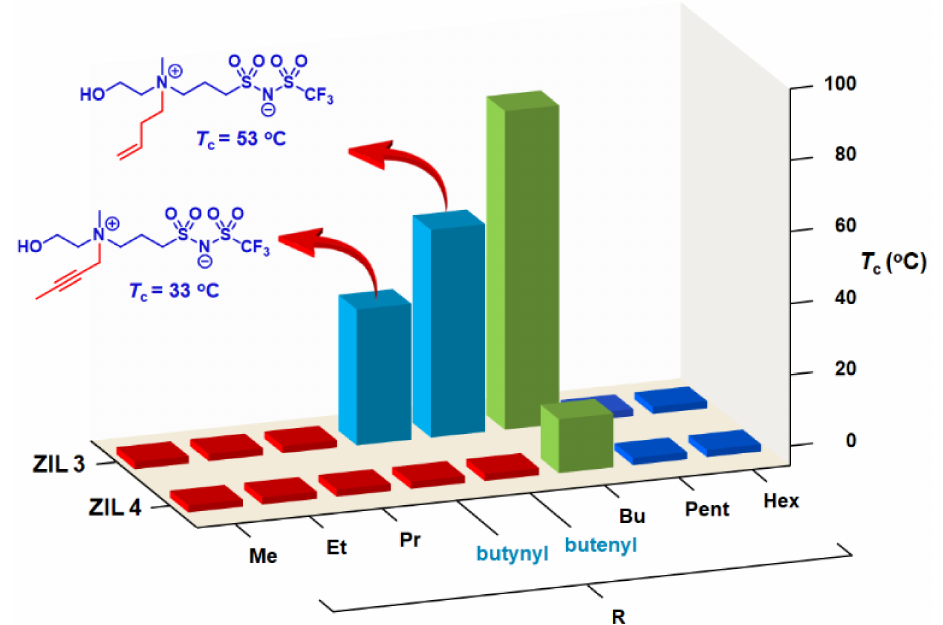
Figure 7. Phase transitions of ZIL 3d-ene , ZIL 3d-yne , ZIL 4d-ene and ZIL 4d-yne , along with ZIL 3a – f and ZIL 4a–f , upon mixing with water (1:1, w/w ) at temperatures between 0 ◦ C and 90 ◦ C. Phase transition results shown in red and blue indicate an entirely homogeneous (one-phase) solution and a heterogeneous (two-phase) mixture, respectively, between 0 ◦ C and 90 ◦ C. Two additional room-temperature ZILs (labeled in sky blue) show phase transitions: ZIL 3d-ene ( T c = 53 ◦ C) and ZIL 3d-yne ( T c = 33 ◦